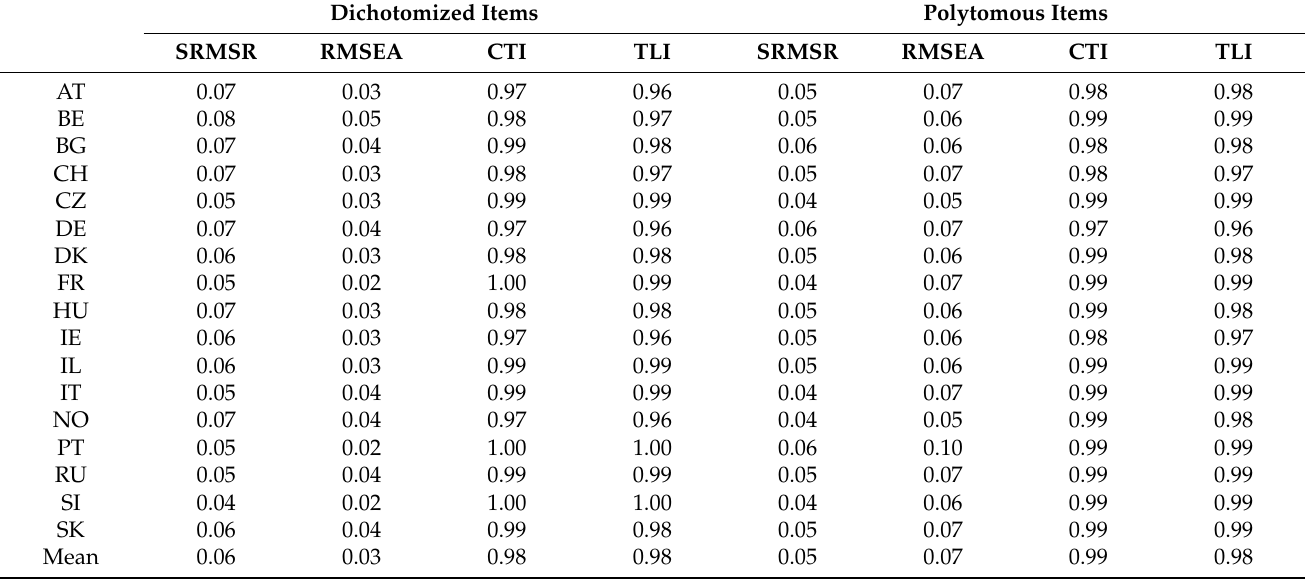
Table 4. Table model fit of the single-factor confirmatory factor analysis for dichotomized and the polytomous